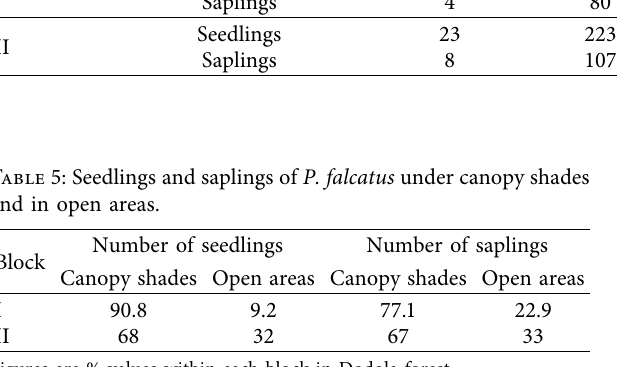
Figures are % values within each block in Dodola